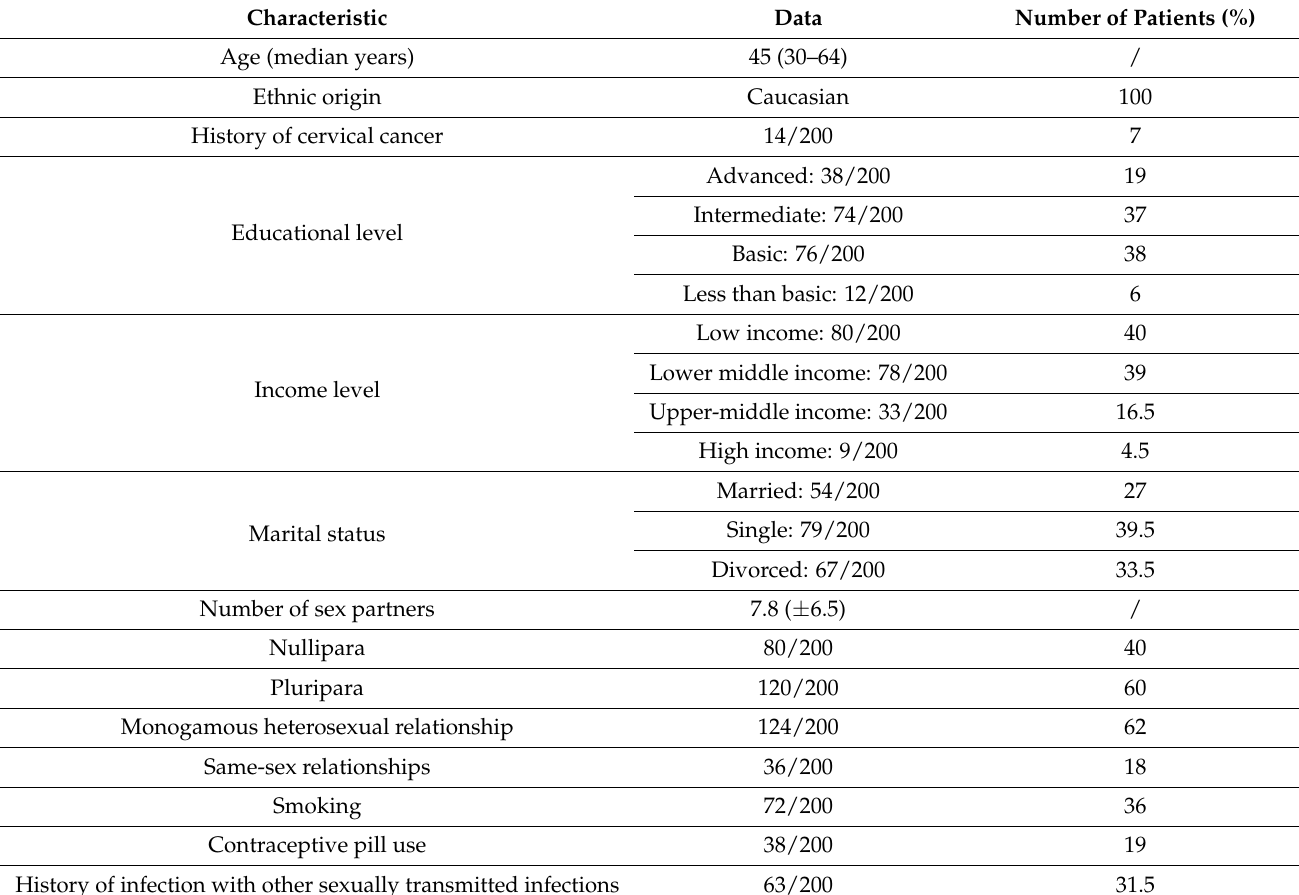
Table 1. Features and risk factors of HPV-positive patients enrolled in the